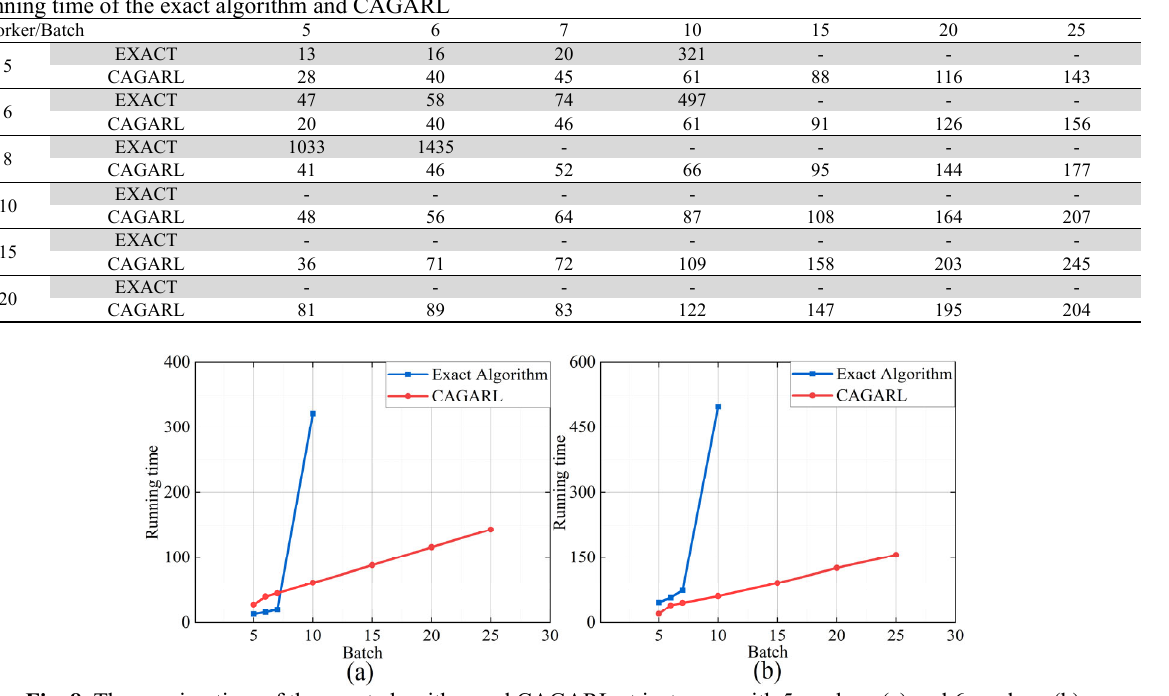
Fig. 8. The running time of the exact algorithm and CAGARL at instances with 5 workers (a) and 6 workers (b) As can be seen from Table 6 and Fig. 8, the exact algorithm only can solve small-scale problems. Compared to the exact of CAGARL can meet the actual needs of